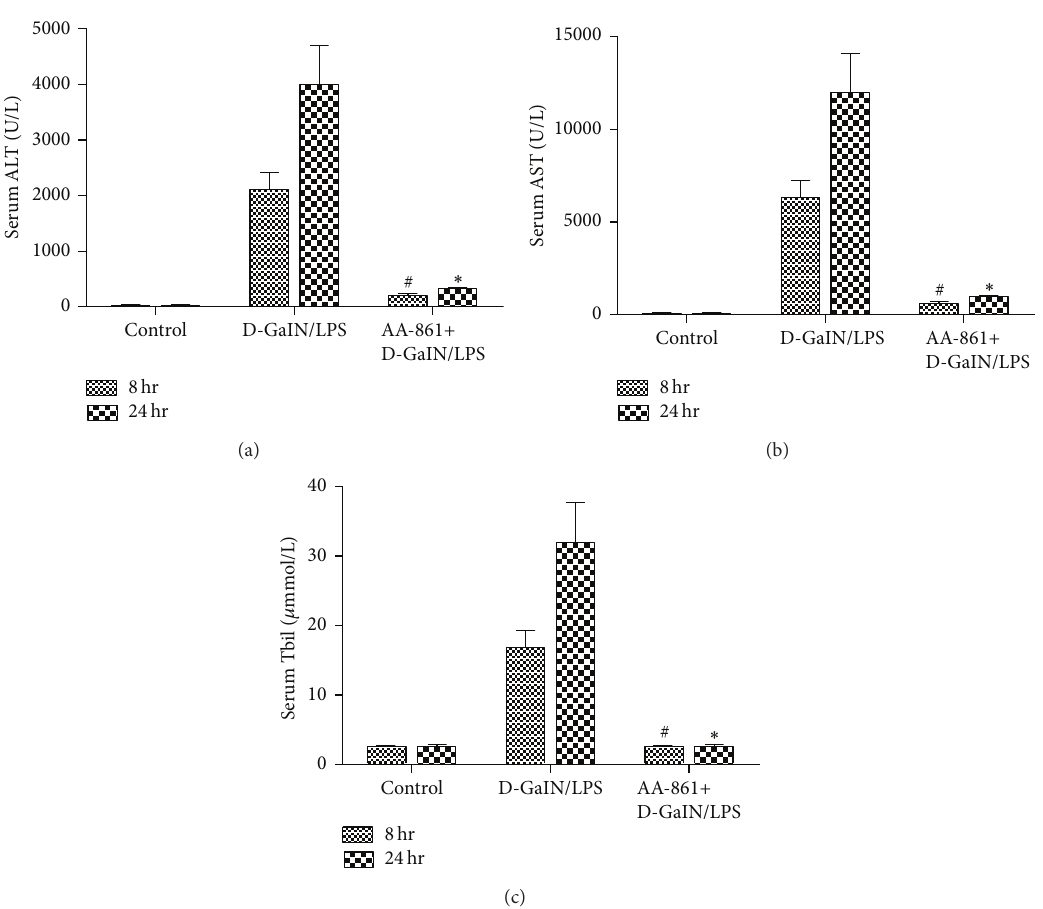
Figure 2: 5-LO specific inhibitor AA-861 decreased levels of serum ALT, AST, and Tbil in D-GalN/LPS-treated rats. ((a)–(c)) Compared with experimental groups, the levels of serum ALT, AST, and Tbil in the AA-861 treatment groups were significantly decreased 8 and 24hr after induction of ALF ( 𝑃 < 0.05